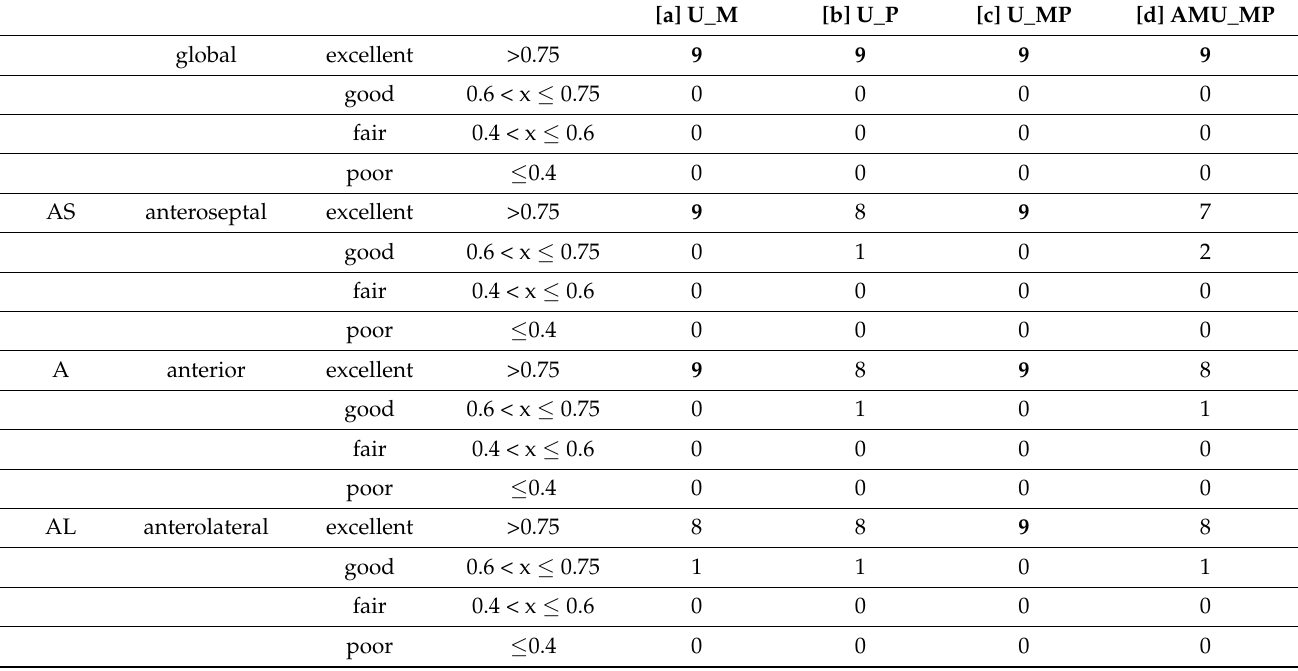
Table 4. Classification of inter-class coefficients (ICCs) of CMR MV markers across